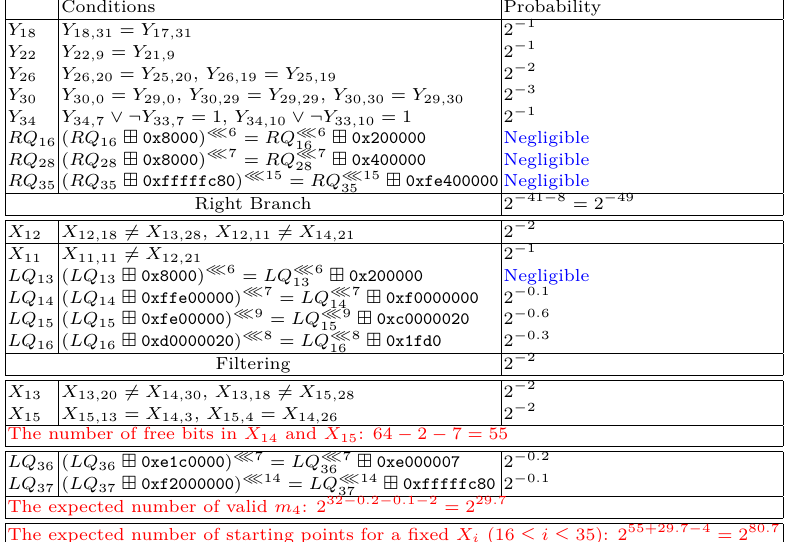
Table 7: Other conditions influencing the attack for the 37-step differential characteristic